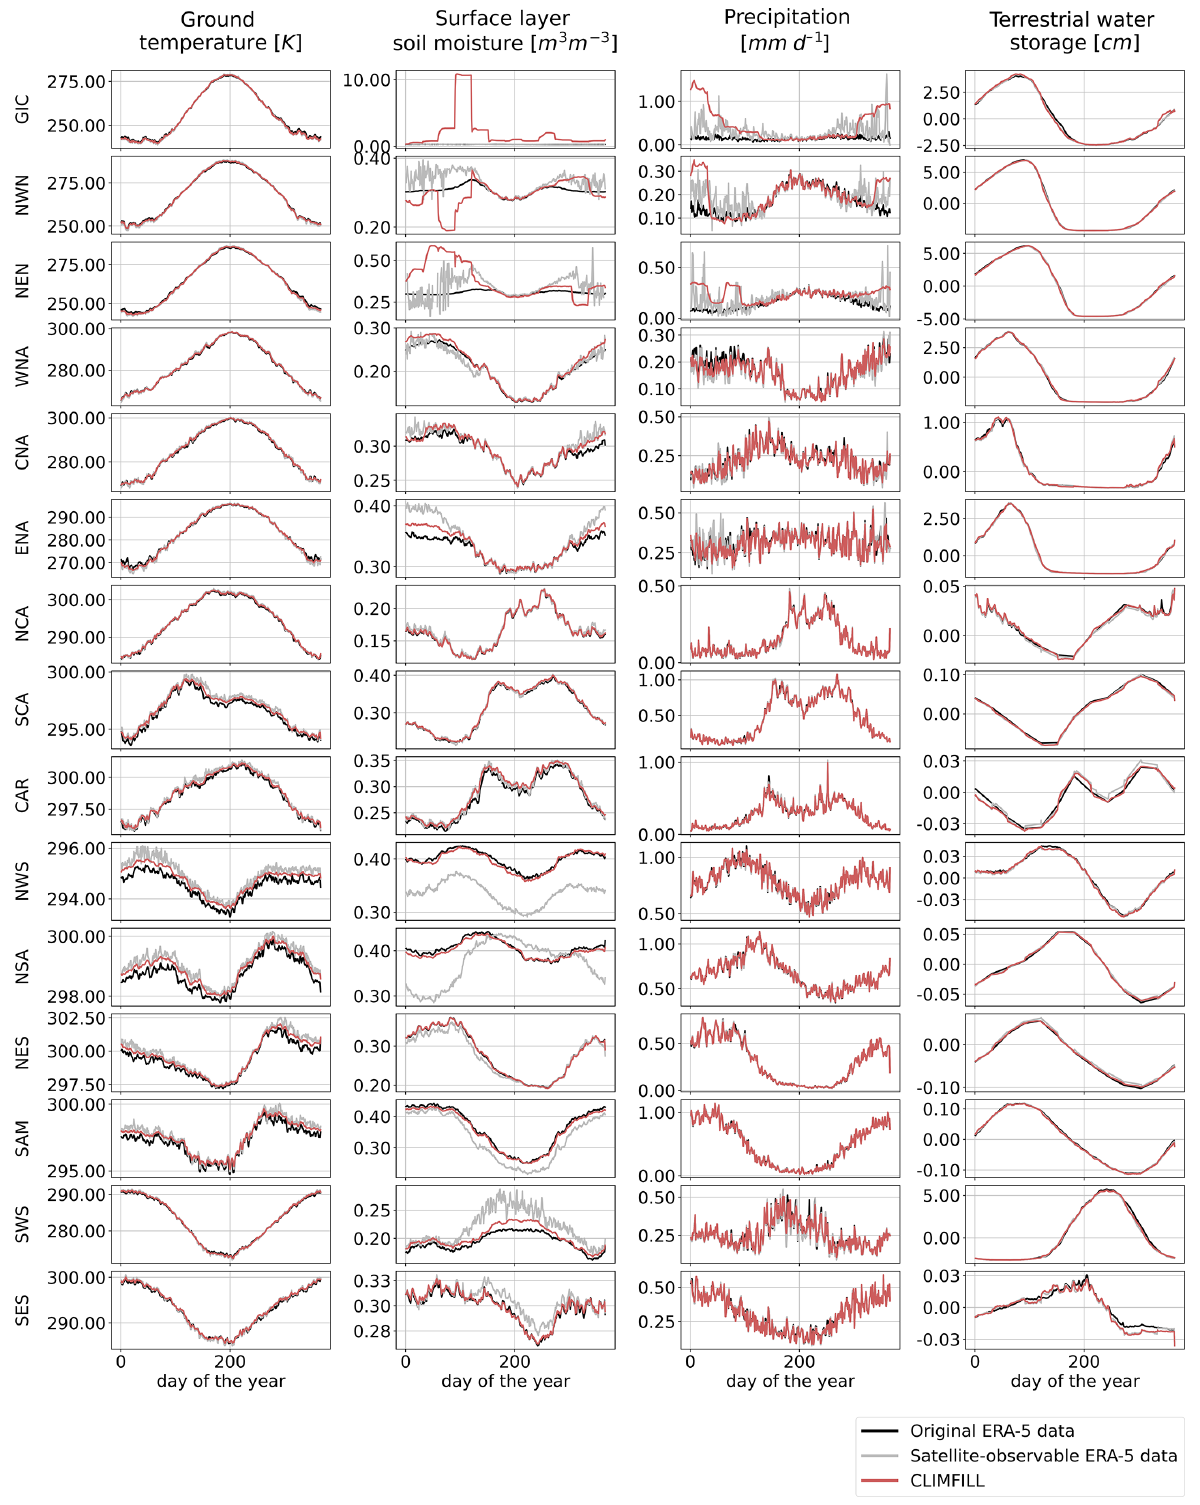
Figure A2. Mean seasonal cycle over all IPCC reference regions on land except Antarctica (AR6 regions, as described in Iturbide et al., 2020) for the original ERA-5 data, satellite-observed ERA-5 data, and data gap filled with CLIMFILL.